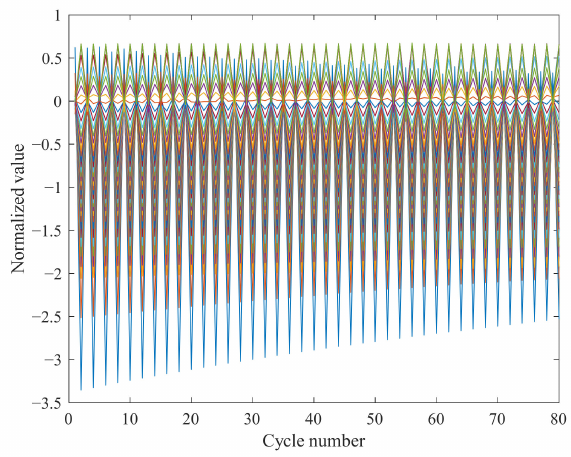
Figure 7. The data matrix